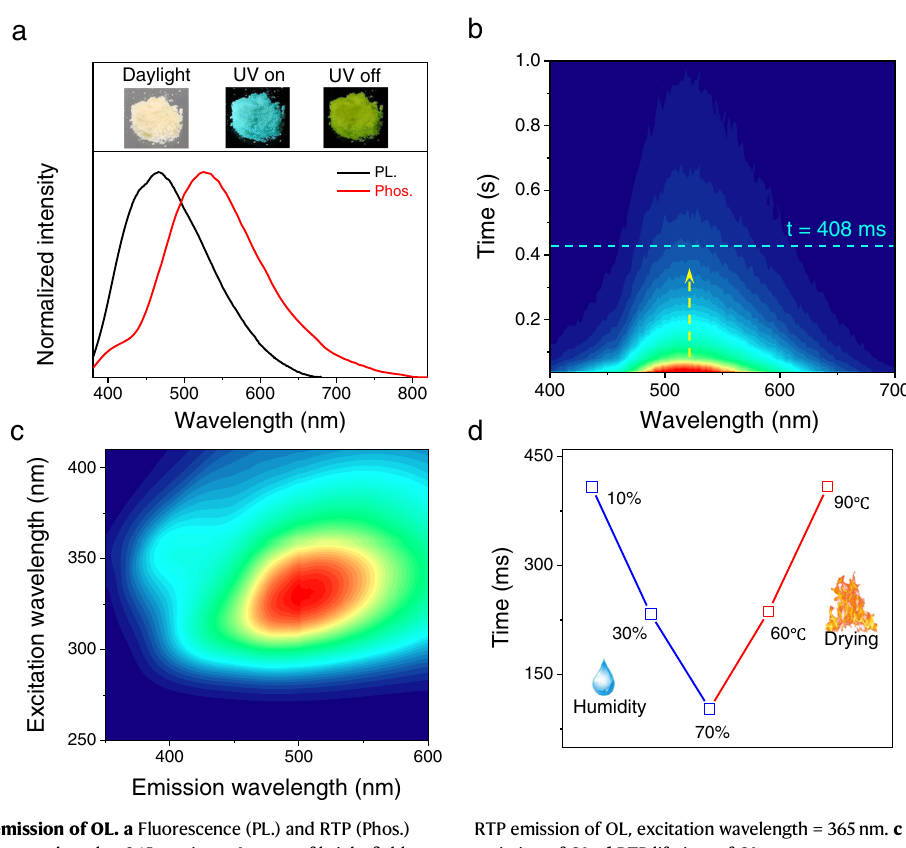
Fig. 2 | Afterglow RTP emission of OL. a Fluorescence (PL.) and RTP (Phos.) emission of OL, excitation wavelength = 365nm, inset: Images of bright fi eld, fl uorescentandRTPemissionofOLuponUVirradiation(365nm). b